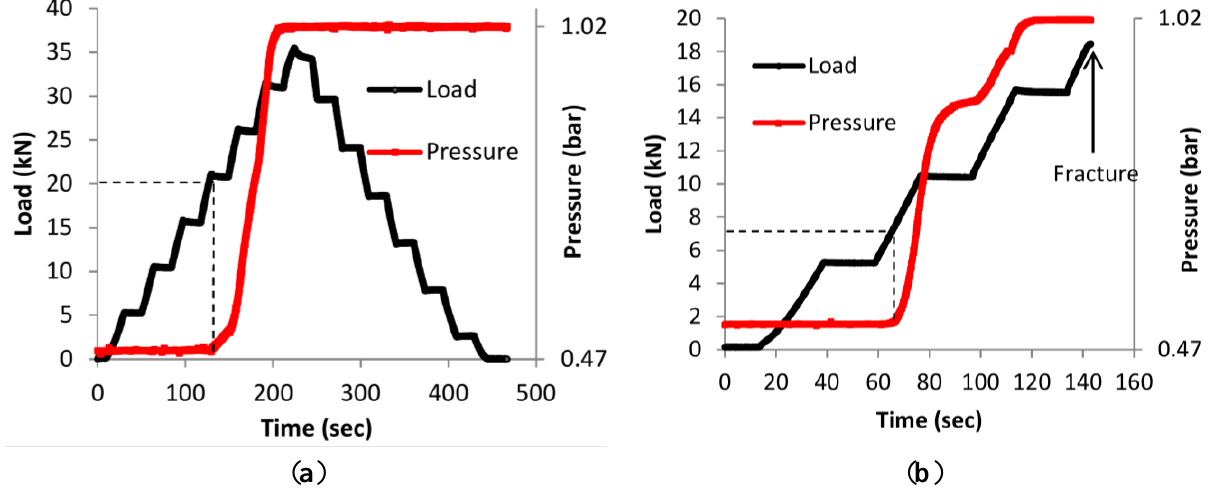
Figure 5. ( a ) Load history and time vs. time for the LMD1 sample; and ( b ) load history and pressure vs. time for the SLM1